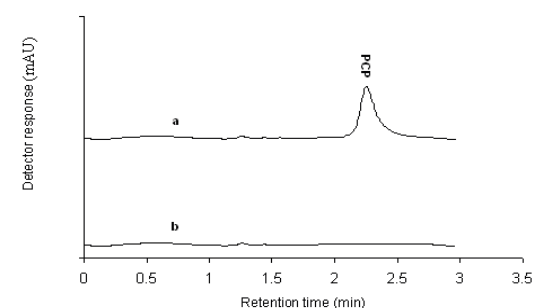
Figure 8. Chromatograms of extracted PCP by proposed DLLME method, (a) standard solution of PCP, 5 µg L -1 ; (b) tap water